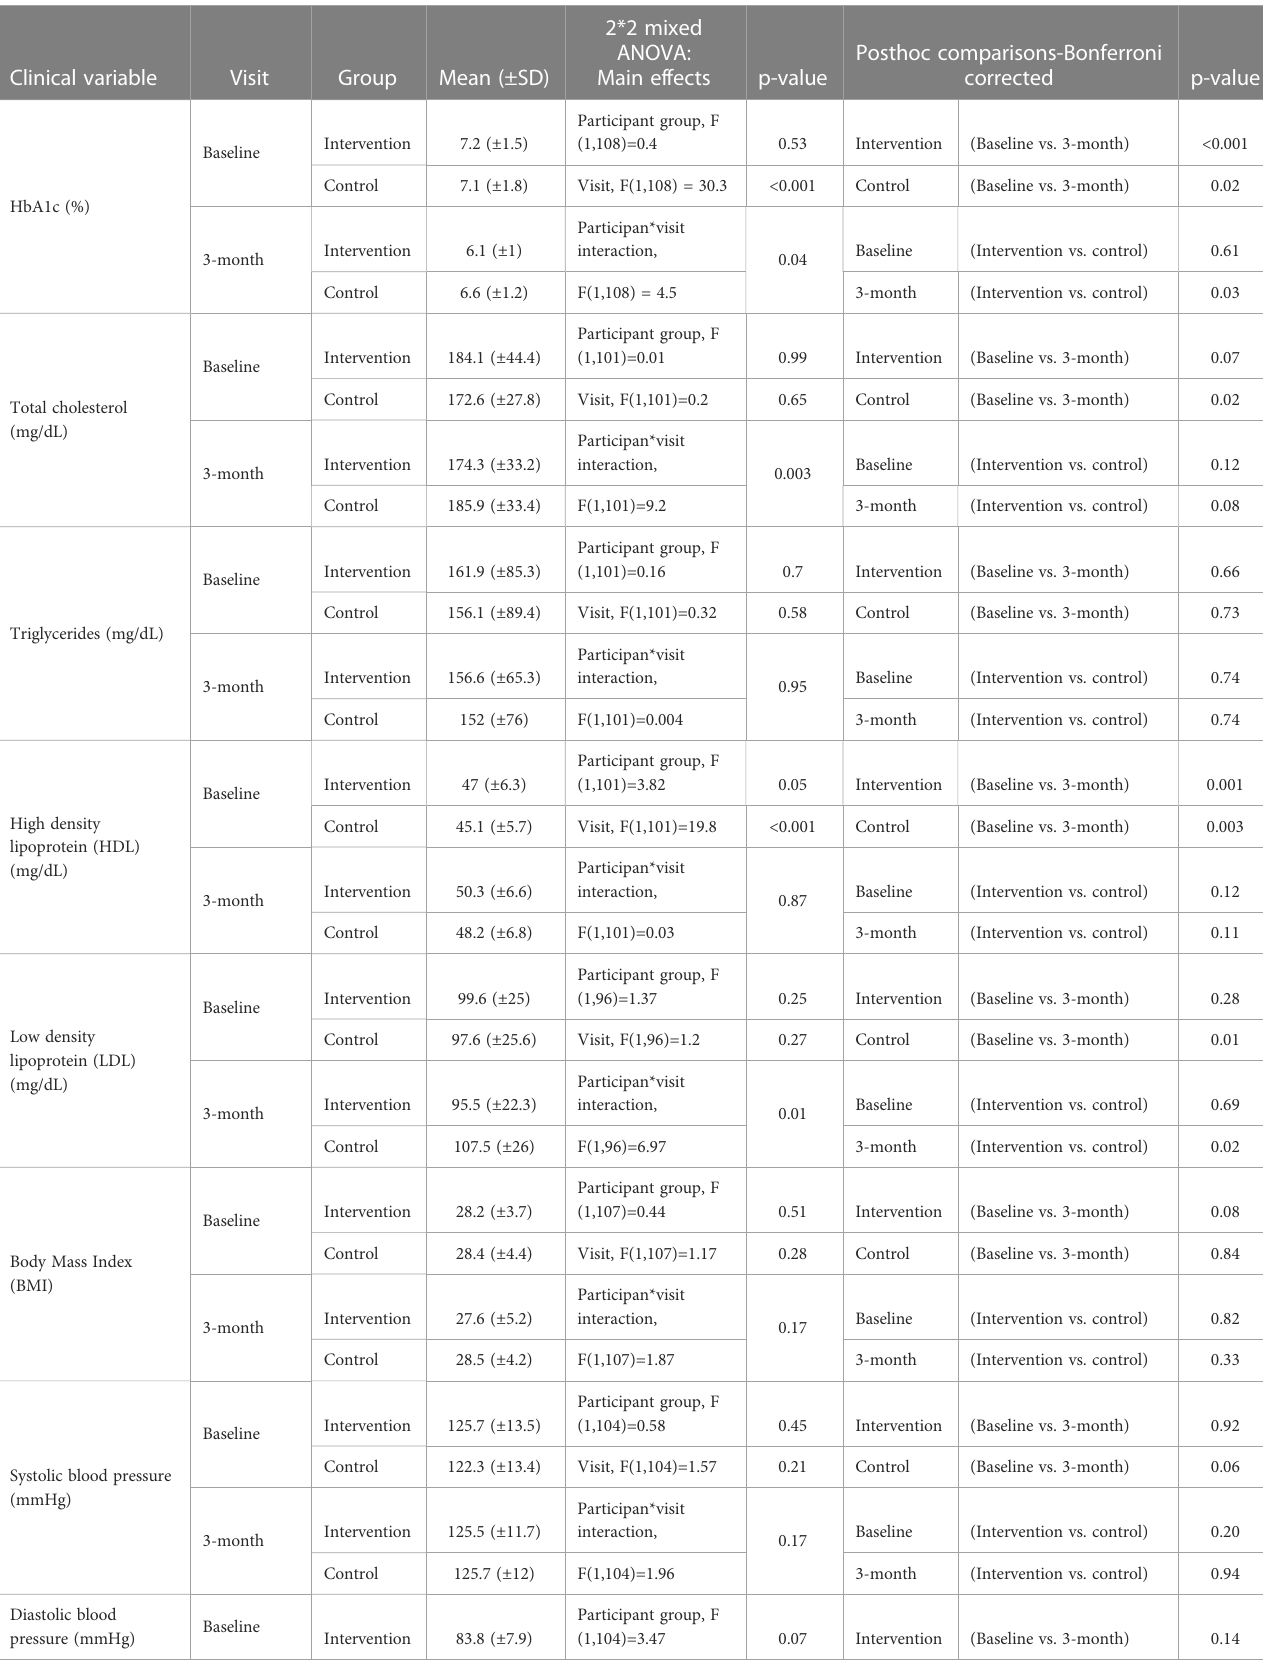
TABLE 1 Mean ( ± standard deviation) for clinical variables measured at baseline and 3-month follow-up visit for participants in the intervention and the control group along with the results of 2 (participant groups) *2 (visits) ANOVA and the Bonferroni corrected post hoc comparisons.